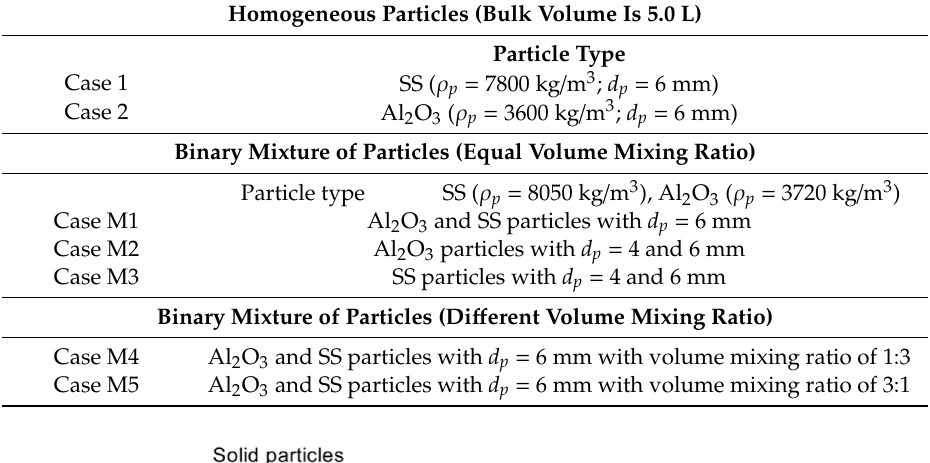
Table 1. Simulation conditions and particle properties.